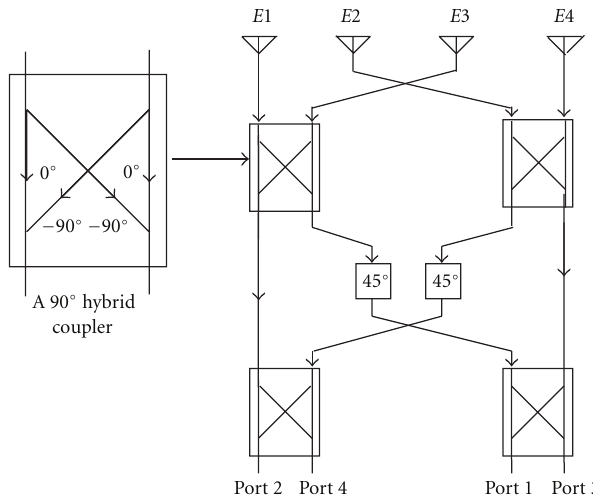
Figure 3: Block diagram of Butler matrix